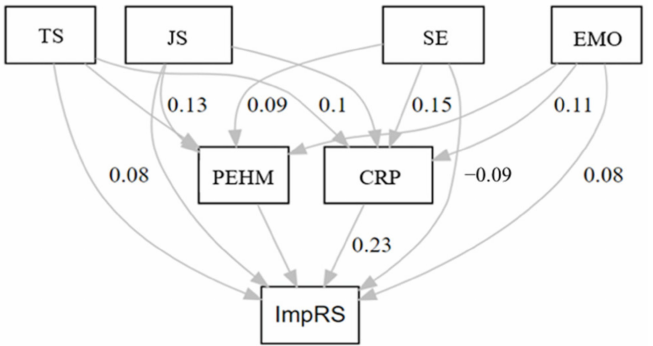
Figure 2. Model 2: COVID-19 pandemic impacts on social relationships. Note: TS = teachers’ stress, JS = job satisfaction, SE = Self-efficacy, EMO = emotional intensity at work, CRP = perception of risk of contracting SARS-CoV-2; PEHM = Perception of the effectiveness of health measures; ImpRS: impact of COVID-19 on relationships at school. Only coefficients of statistically significant paths (solid lines) are